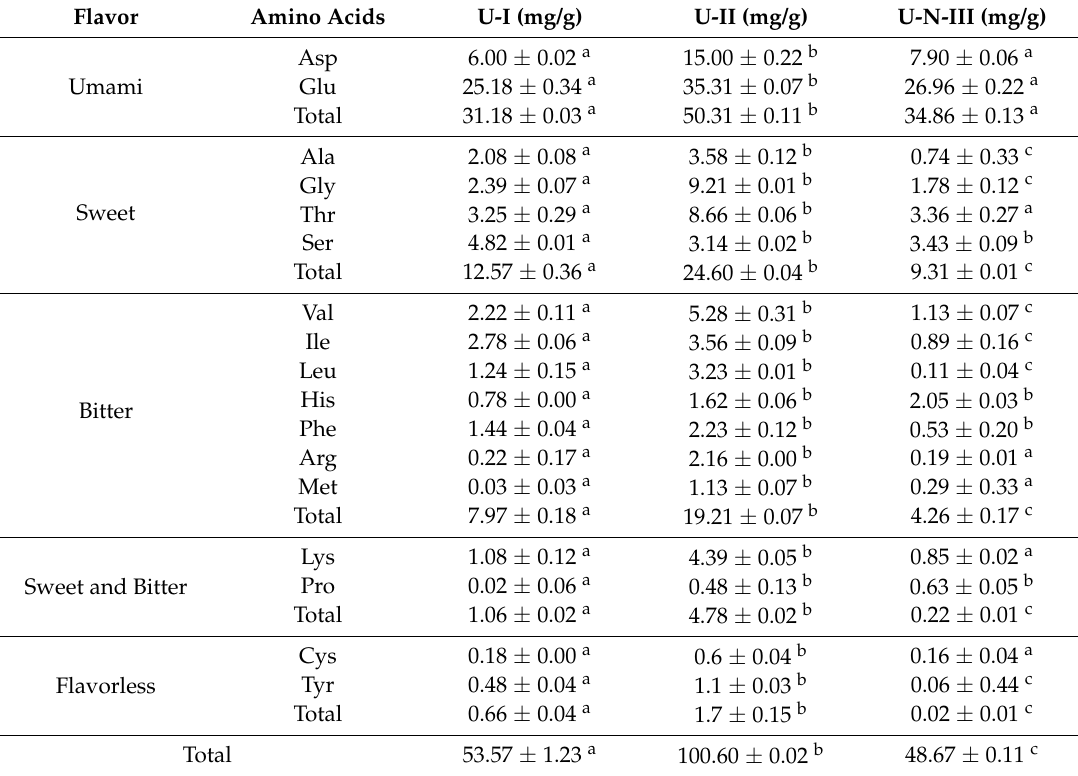
00.81.62.43.244.85.66.47.2mV